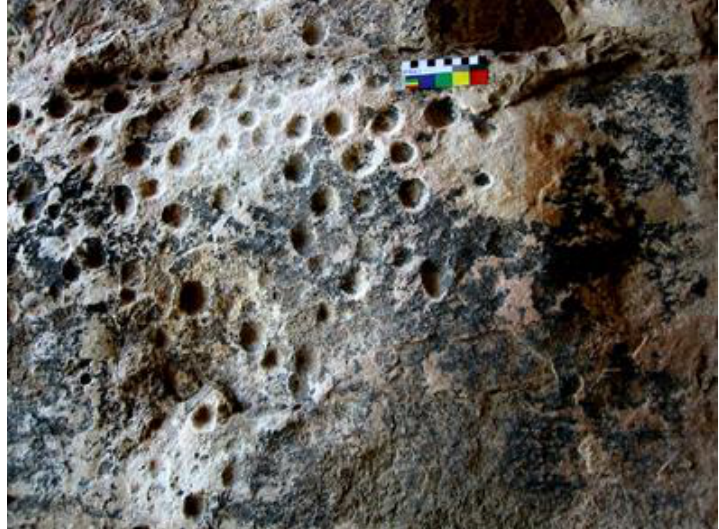
Figure 21. Some of the over 500 cupules in Daraki-Chattan, at least some of which have been demonstrated to be of a chopping tool industry found below Acheulian deposits; central